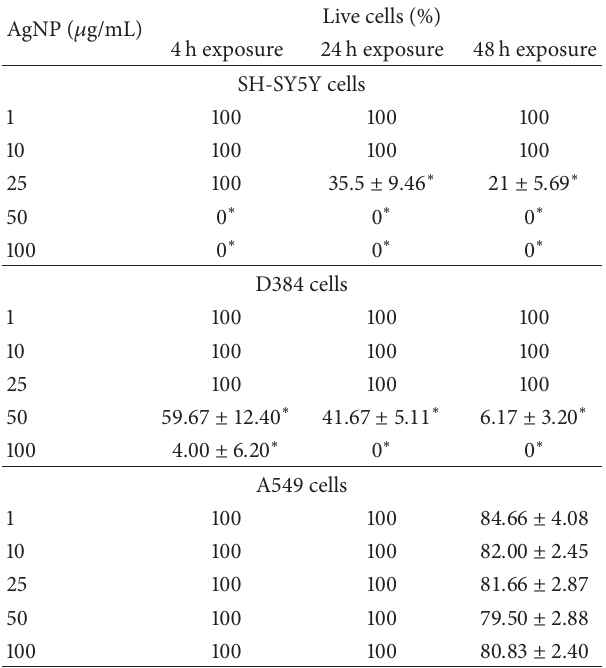
Mean of 6 images for each cell type and each dose of AgNPs. ∗ Statistical analysis by ANOVA with Tukey’s test compared to its control ( 𝑃 < 0.05 ).